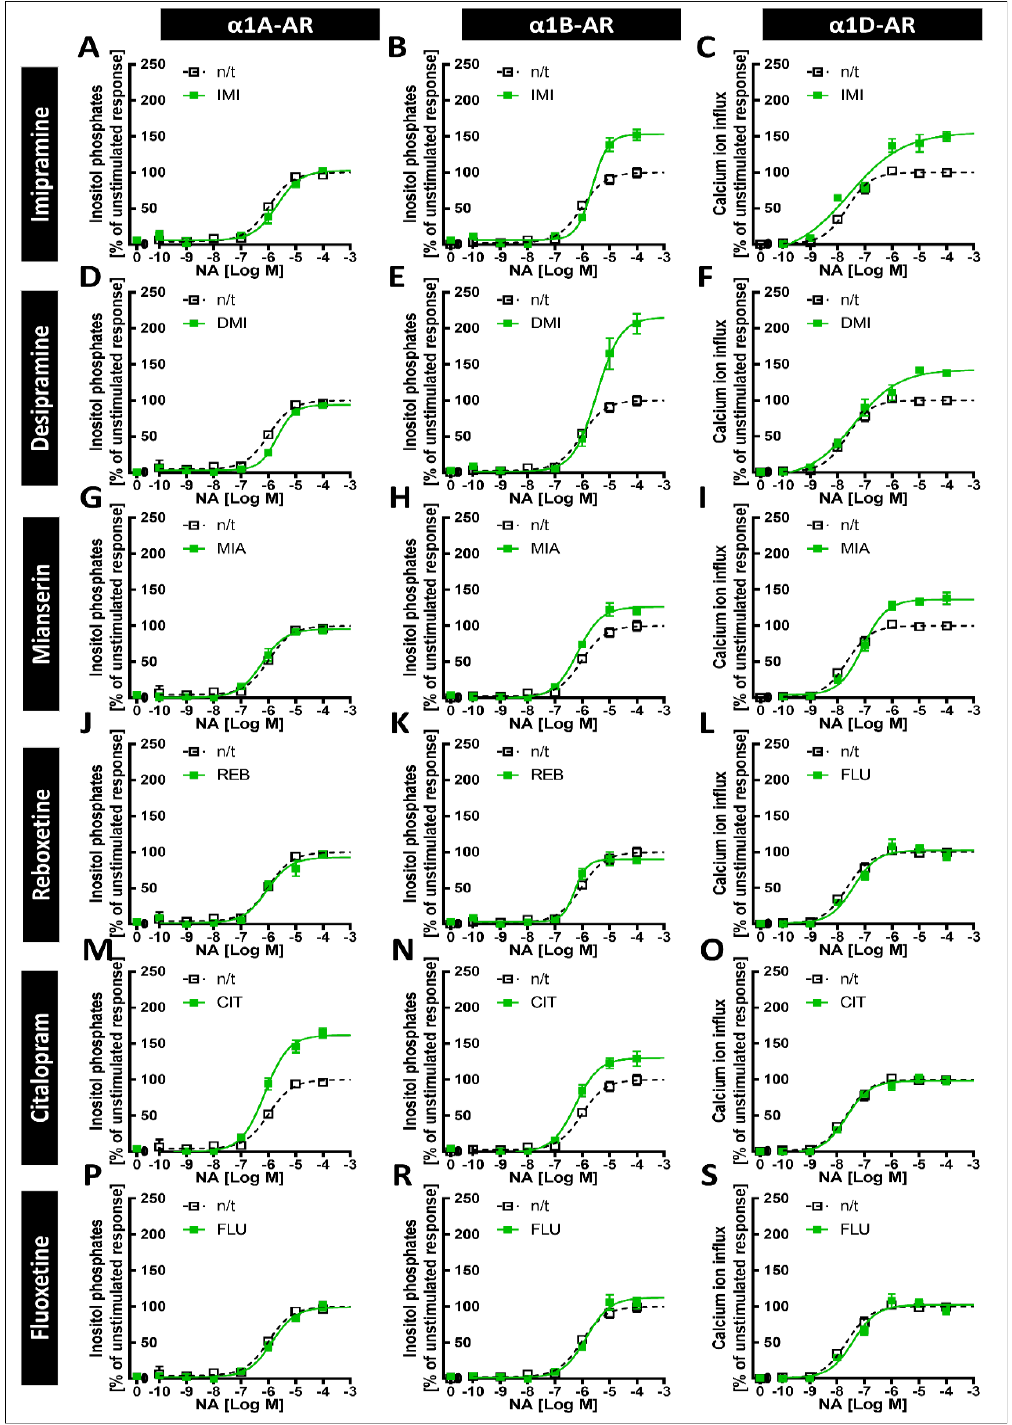
Figure 6. Dose–response curves for noradrenaline and the α 1A-, α 1B- and α 1D-adrenergic receptor subtypes’ second messenger responses after a 120 h preincubation with the chosen antidepressant drugs. The graphs show the responses of cells after preincubation with the antidepressant imipramine (IMI, ( A – C )), desipramine (DMI, ( D – F )), mianserin (MIA, ( G – I )), reboxetine (REB, ( J – L )), citalopram (CIT, ( M – O )) or fluoxetine (FLU, ( P – S )) (green solid lines on the respective graphs), or the responses of control cells (black dotted lines on all graphs). The effects were tested by measuring inositol phosphate production by cells expressing α 1A-AR ( A , D , G , J , M , P ) or α 1B-AR ( B , E , H , K , N , R ), or by measuring the noradrenaline- induced calcium ion influx of ChemiSCREEN™ Ready -to- Assay™ α1DA -AR-expressing cells ( C , F , I , L , O , S ). Each value represents the mean ± S.E.M. of at least four independent experiments conducted in duplicate.